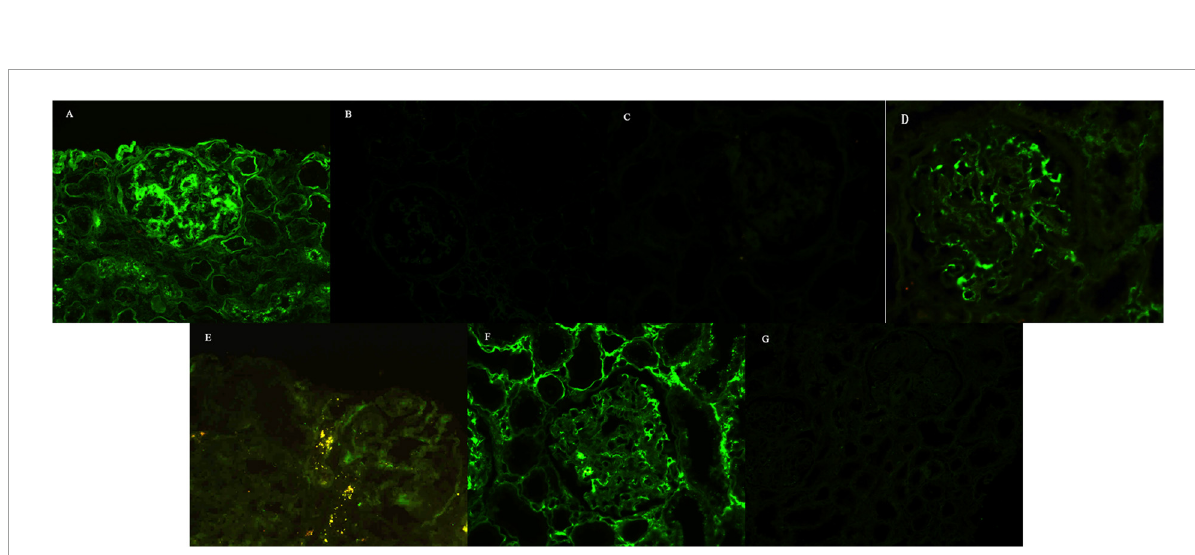
FIGURE2 Immunofluorescence findings. (A) IgA linearly deposited along the GBMs and segmentally along the TBMs, while it was coarsely granularly deposited in the mesangial regions, with 3 + intensity (Patient 1, × 100). Staining for κ -chain (B) and λ -chain (C) was negative (Patient 1, × 100). Staining for IgG (D) and IgG2 (E) revealed coarse granular deposition only in the mesangial regions, without deposition along GBMs and TBMs (Patient 5, × 200). Restrictive κ -chain (F) was linearly deposited along the GBMs, segmentally deposited along the TBMs, and granularly deposited in the mesangial regions, while staining for λ -chain (G) was negative (Patient 5, ×